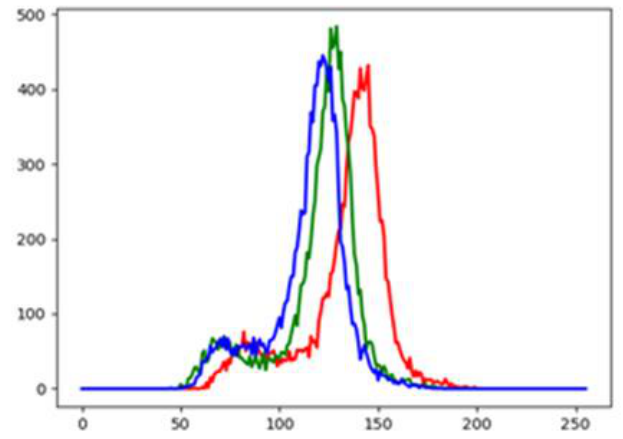
Figure 7. RGB histogram of insulator.